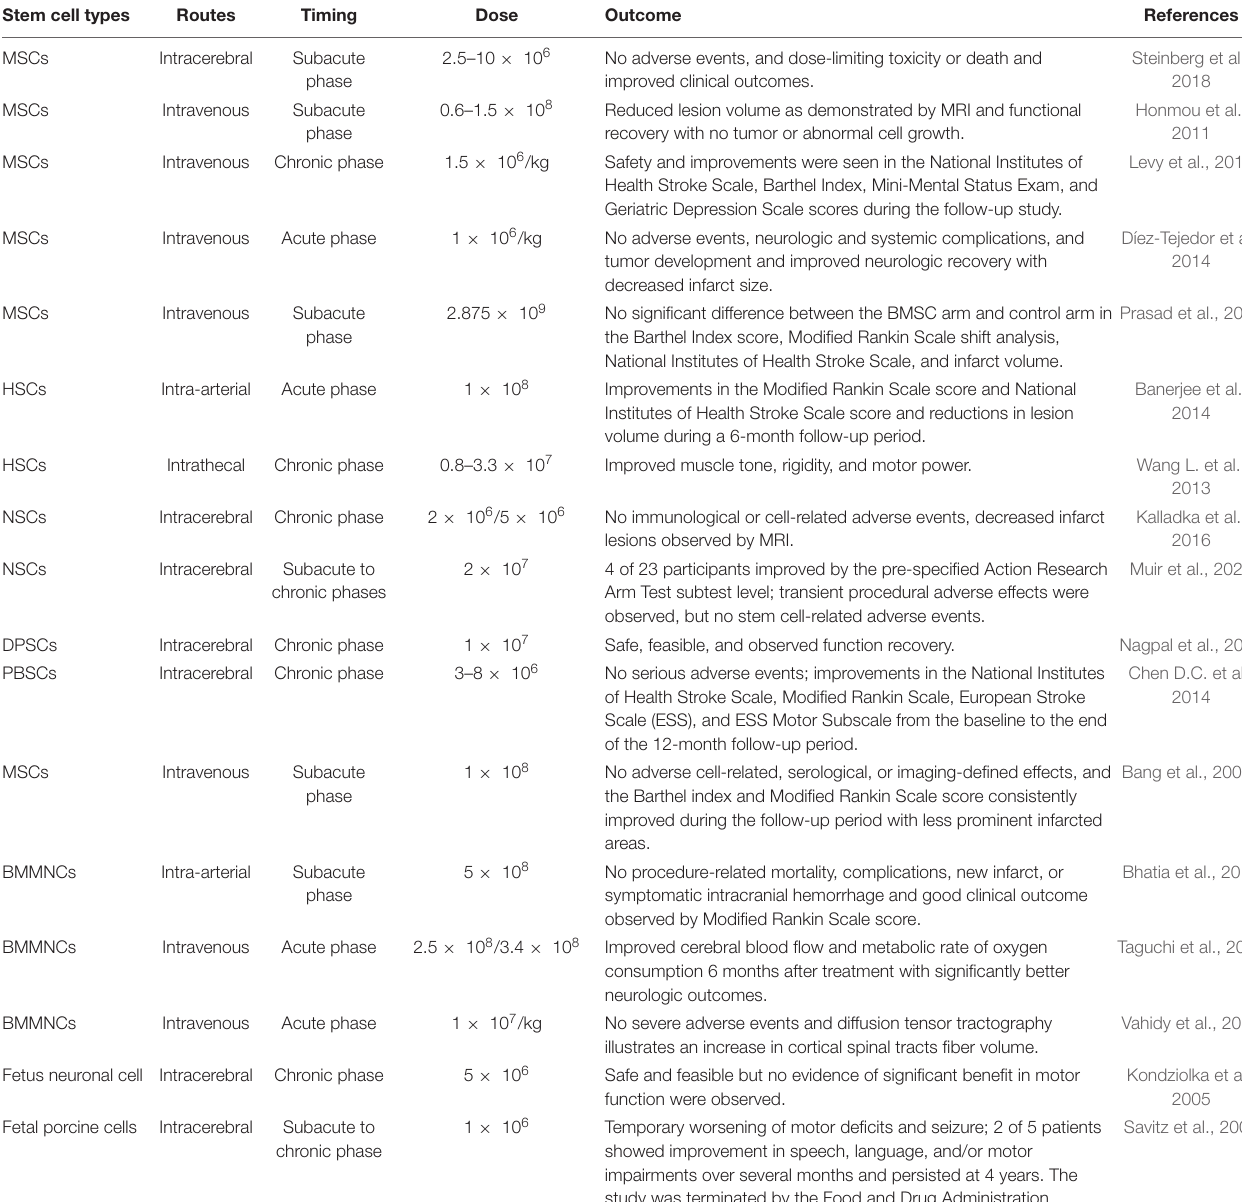
TABLE 1 | Summary of stem cells administered in clinical